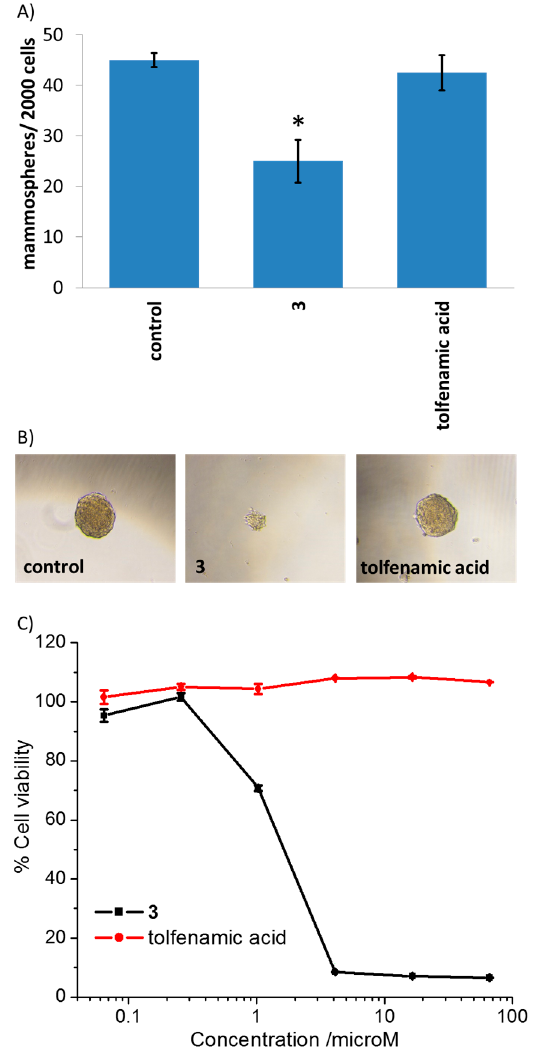
Figure 3. ( A ) Quantification of mammosphere formation with HMLER-shEcad cells untreated and treated with 3 or tolfenamic acid (at their IC 20 values, 5 days). Error bars represent standard deviations and Student’s t -test, * p < 0.05. ( B ) Representative bright-field images (×10) of HMLER-shEcad mammospheres in the absence and presence of 3 or tolfenamic acid (at their IC 20 values, 5 days). ( C ) Representative dose–response curves for the treatment of HMLER-shEcad mammospheres with 3 or tolfenamic acid after 5 days of incubation.